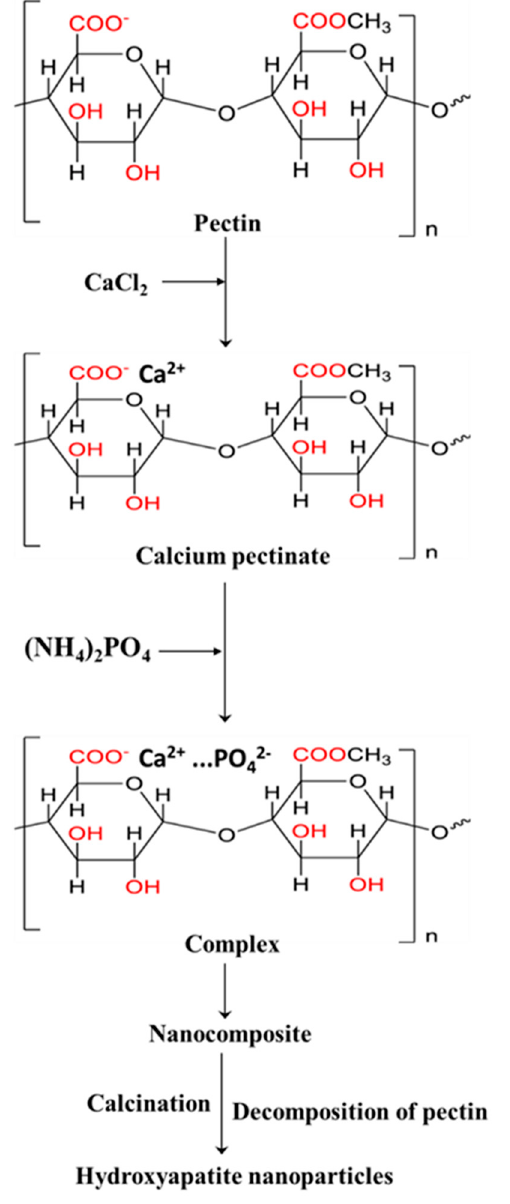
Figure 6. The mechanism for forming HA nanoparticles is adopted from [24,34].